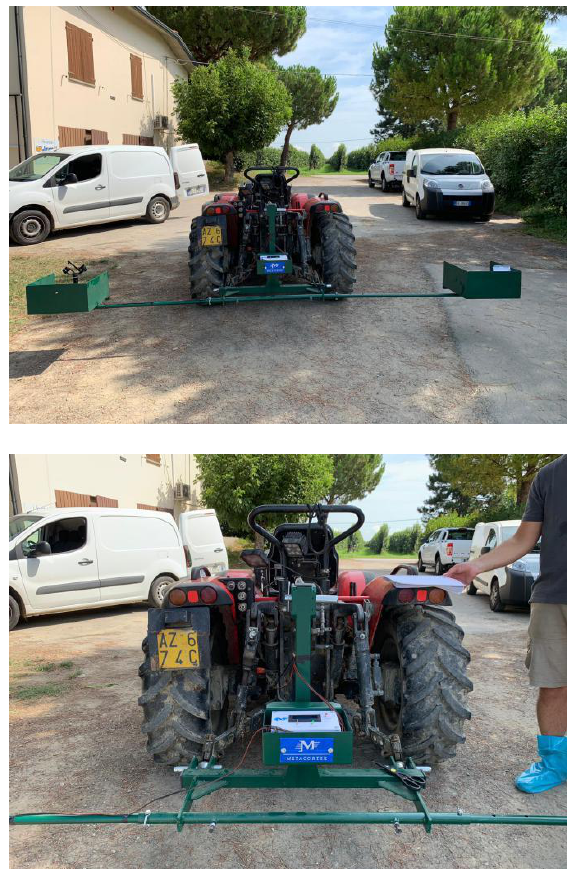
Figure 1. The horizontal bar carrying the other prototype components mounted at the rear of the minitractor.